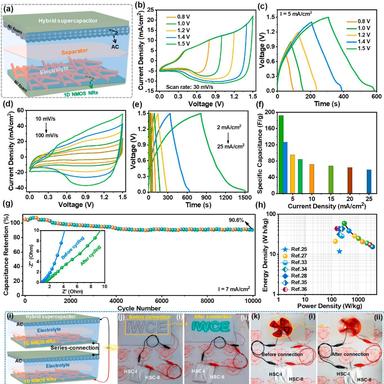
(a) Schematic illustration for the assembly of HSC with NMOS-1:3 and AC as the cathode and anode, respectively. (b) CV and (c) GCD curves of HSC measured within the different voltage windows at the constant scan rate of 30 mV/s and current density of 5 mA/cm2 . (d) CV curves and (e) GCD curves of HSC tested at various scan rates and current densities within the optimized voltage window of 0–1.5 V. (f) Specific capacitance values of HSC device. (g) Cycling stability results and (h) Ragone plot of the HSC dev